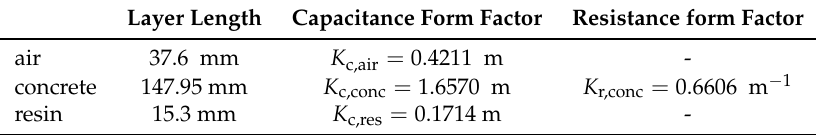
Table 1. Values of the form factors associated with the different layers of